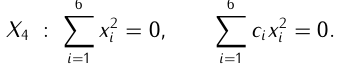
Figure 12. The critical points of